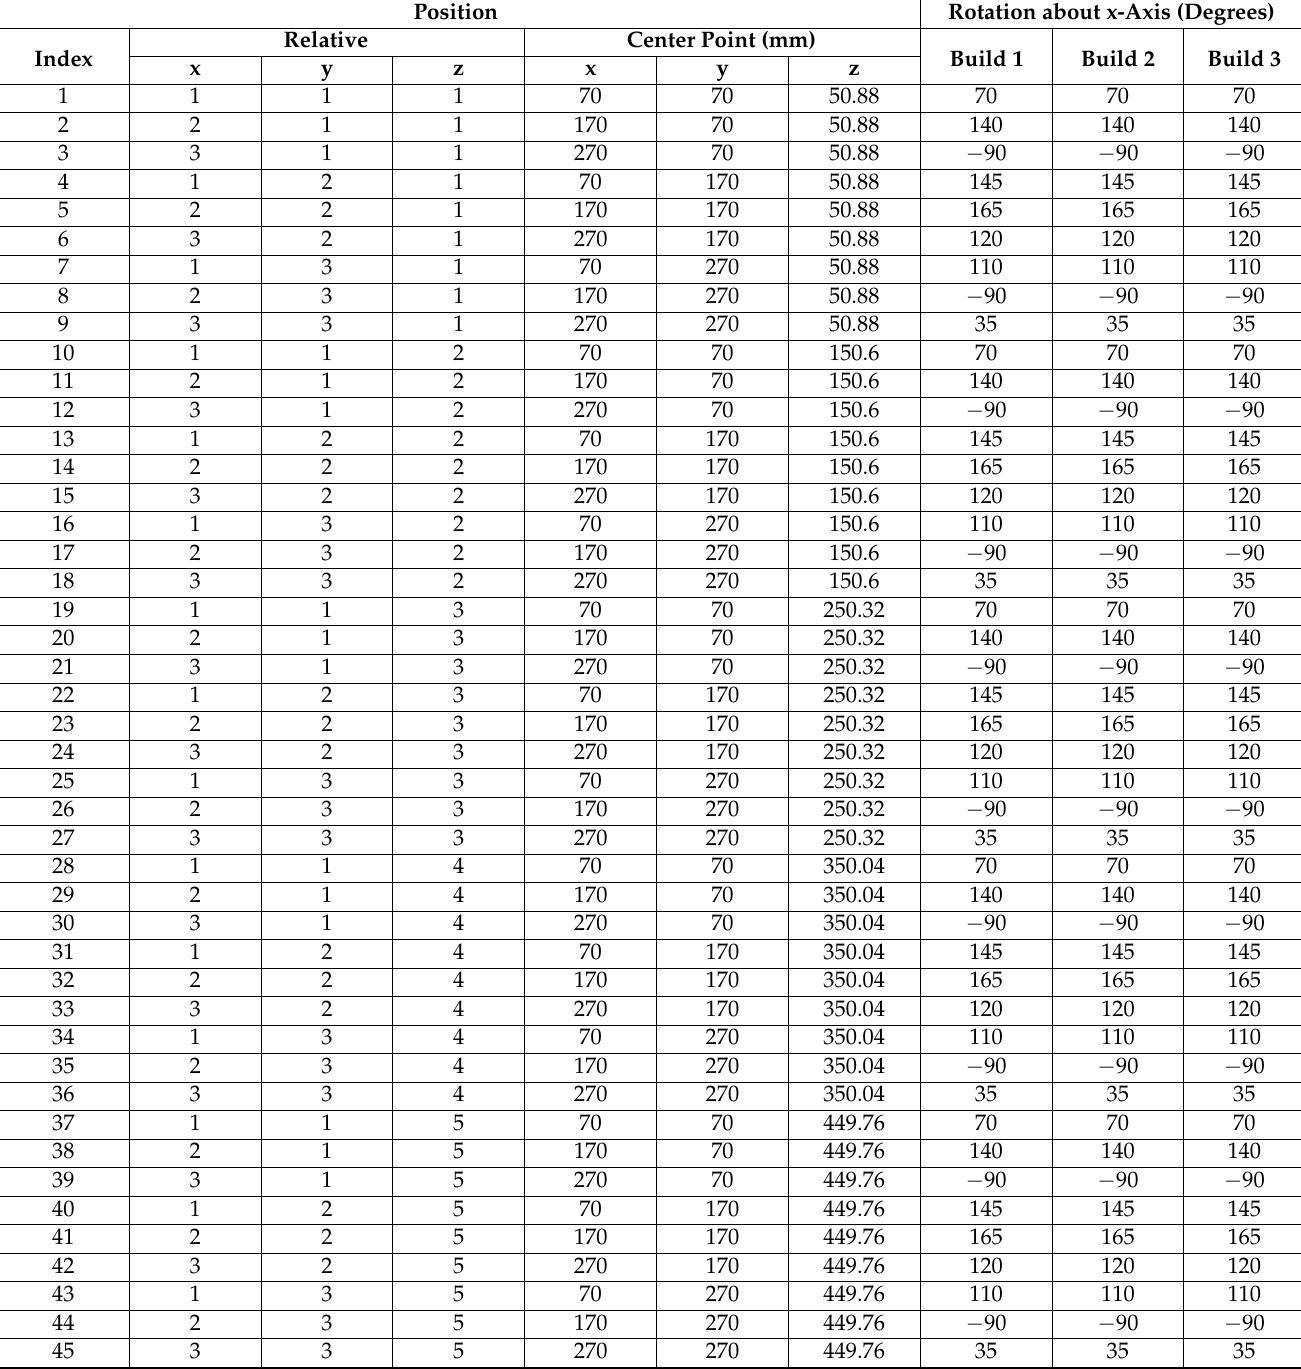
Table A1. Overview of all defined positions in the build space and the orientation fabricated in each position and for each build. The anchor positions are highlighted for